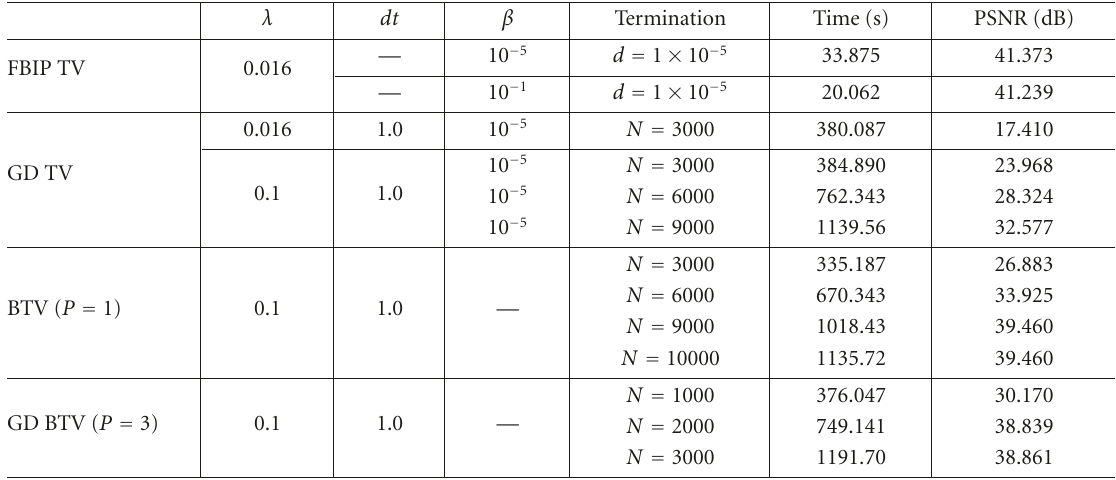
Table 3: Comparison with GD TV and BTV algorithms in the synthetic “missing” case (4 frames).